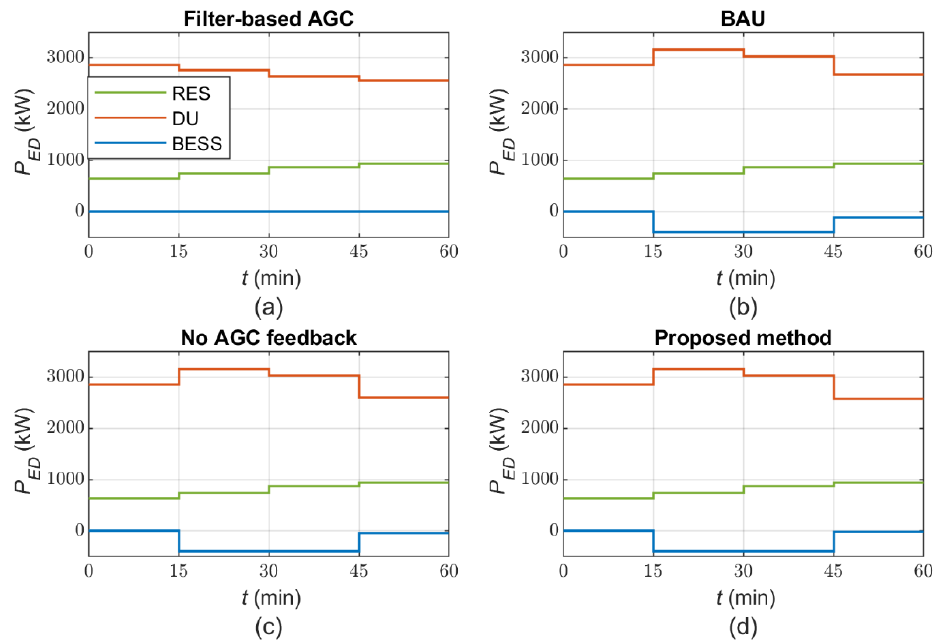
Figure 10. Economic dispatch results, for cases (i)–(iv). ( a ) Filter-based AGC, ( b ) BAU, ( c ) no AGC feedback, ( d ) proposed method.